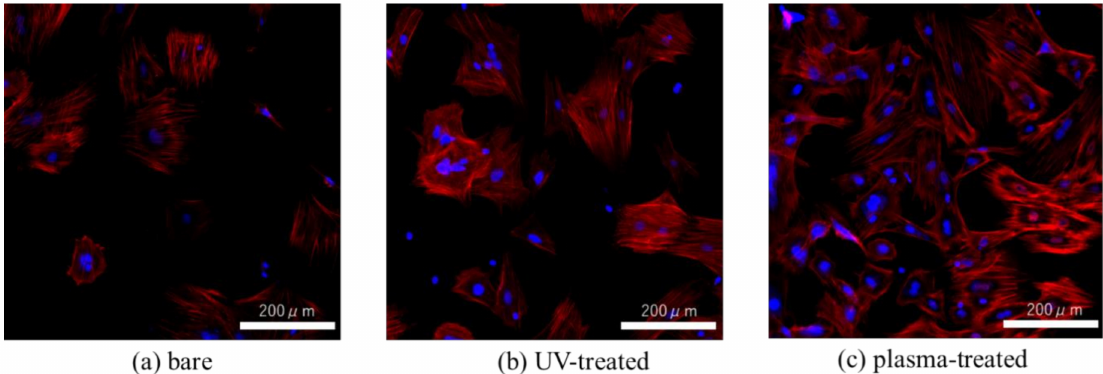
Figure 7. Fluorescent stained image of ( a ) bare, ( b ) UV-treated, ( c ) plasma-treated Ti-QCM sensors were seeded with rat bone marrow mesenchymal stem cells and stained with phalloidin (F-actin) and DAPI (nucleus) 24 h later.